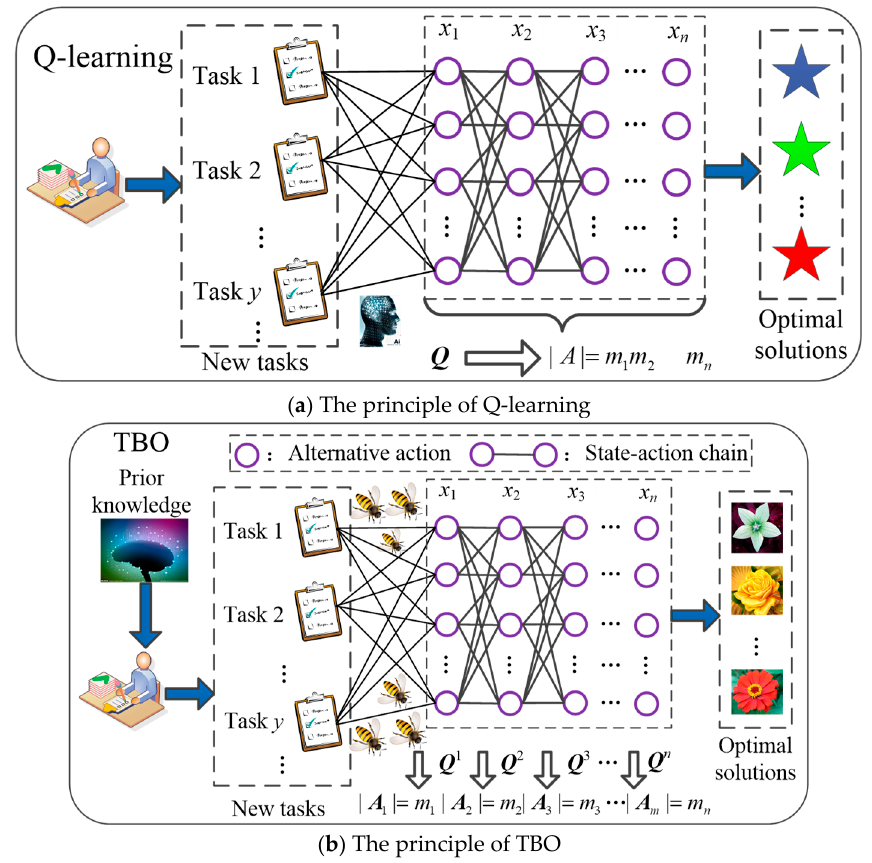
Figure 1. Comparison of Q-learning and transfer bee optimizer (TBO).